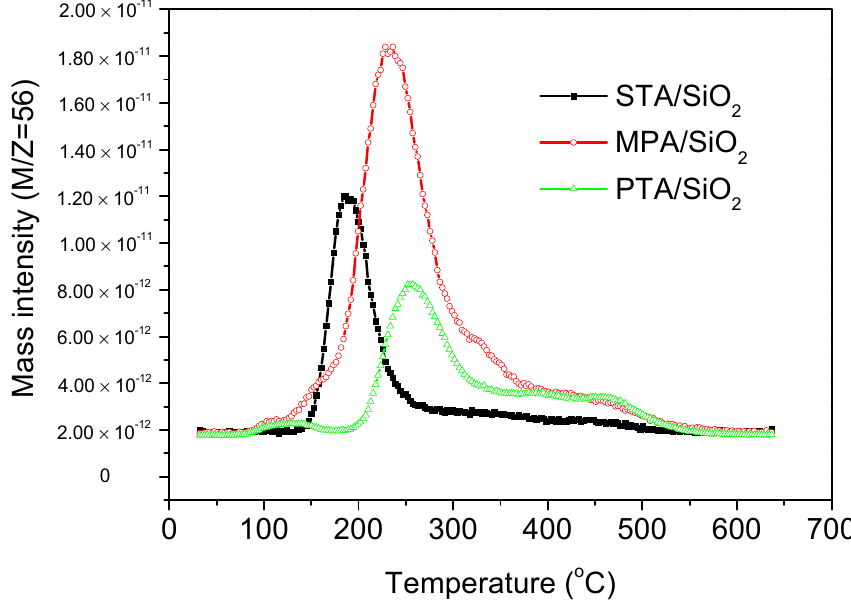
Figure 4. Acrolein in the TPSR of supported heteropoly acid catalysts.